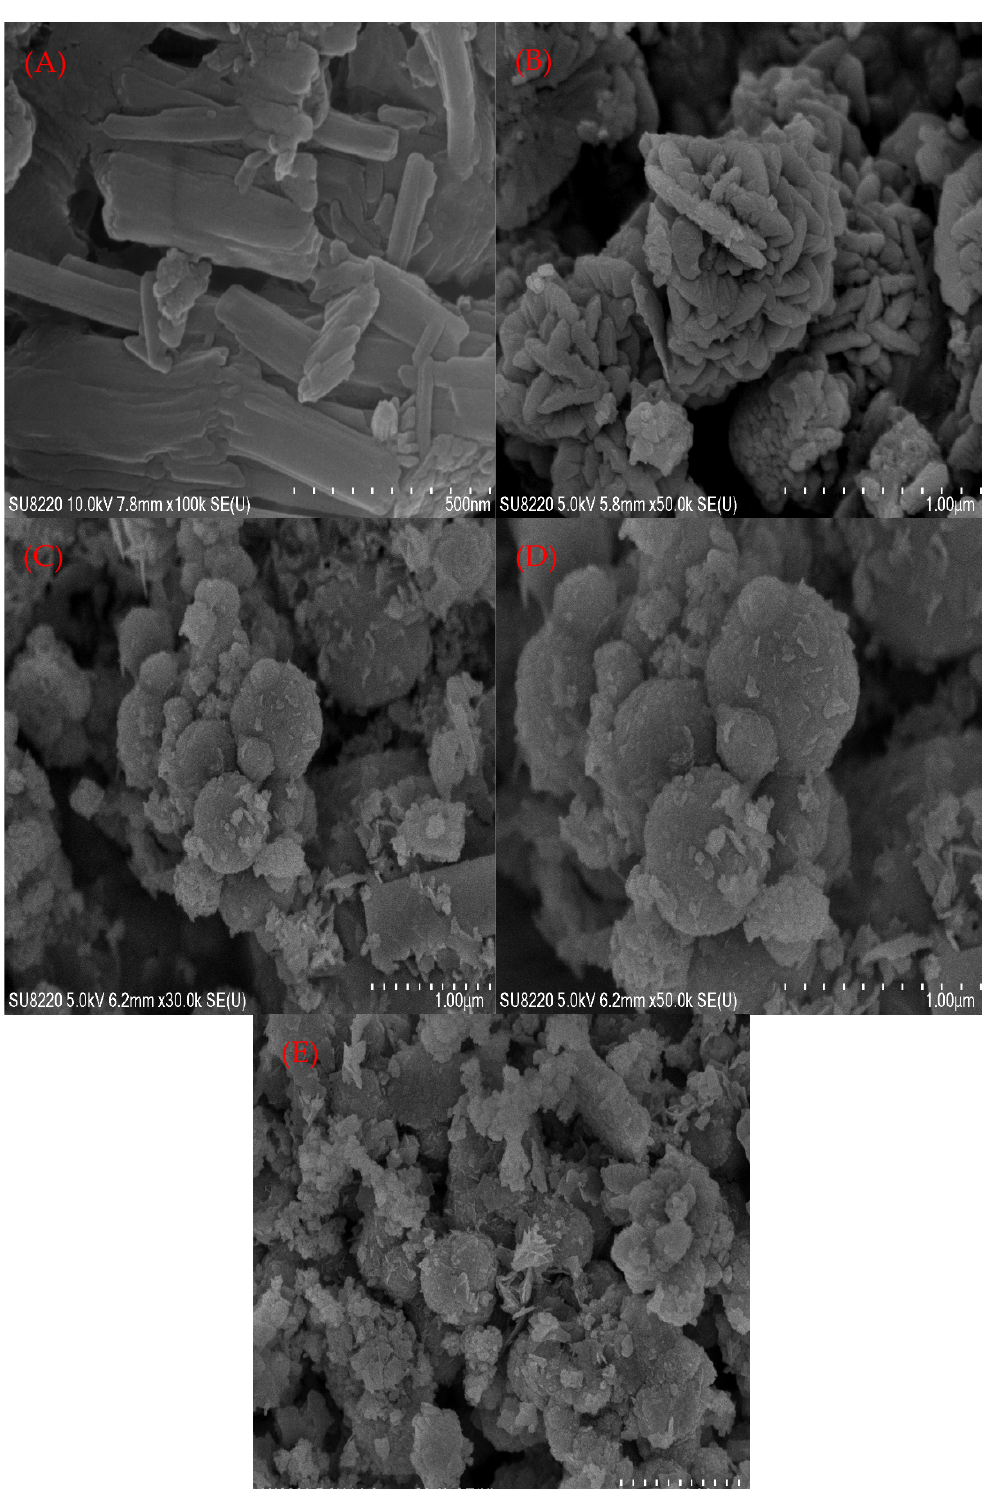
Figure 3. SEM images of ( A ) BFS; the product samples obtained at reaction temperature of ( B ) 80 °C; ( C ) 90 °C; ( D ) 100 °C and ( E ) 120 °C.